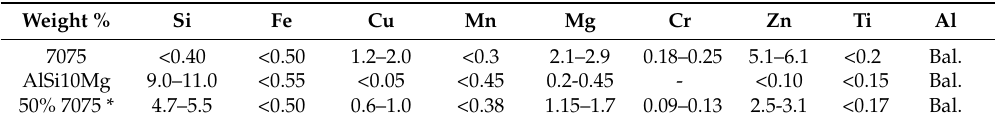
Table 1. Nominal chemical composition of the powders.